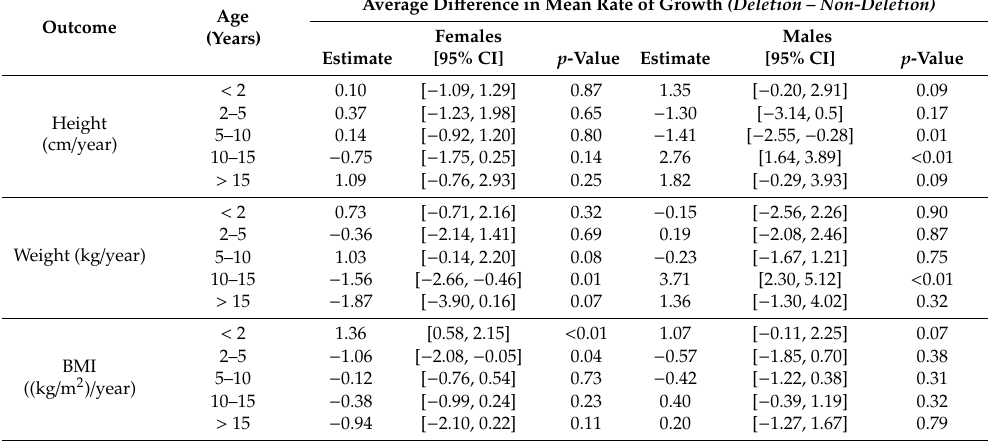
Table 3. Mean di ff erence in the rate of growth across age intervals, between individuals with the deletion or non-deletion mechanism of PWS, estimated using linear mixed models with linear splines (unadjusted), with an interaction term between age and genetic subtype.